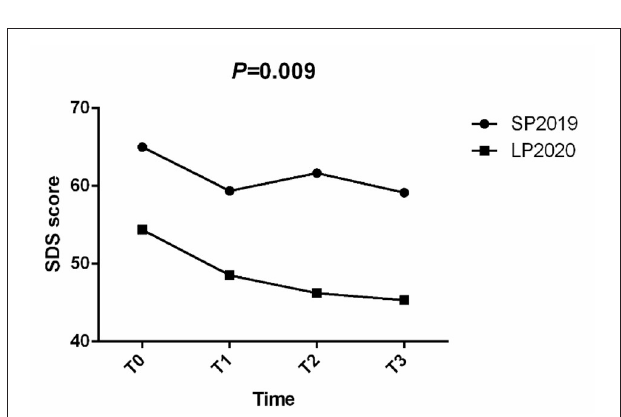
FIGURE 5 | SDS scores at T0, T1, T2, and T3, by group (SP2019, LP2020).